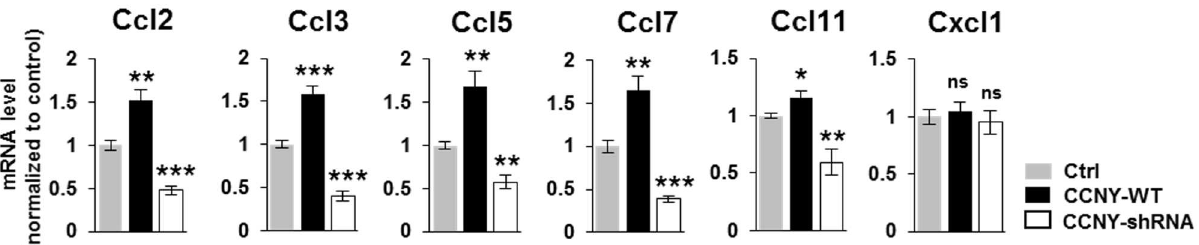
Fig 5. CCNY regulates genes related to Alzheimer’s Disease(AD) in hippocampal neurons. qRT-PCR results of severalcytokine genes in the chemokine signalingpathway (S3a Fig) or genes related to AD from CCNY overexpression or knockdown samples. n = 3–5 from 3 independentexperiments. * p < 0.05relative to control, ** p < 0.01 relative to control, *** p < 0.001relative to control, ns, not significant, student’s t test. Refer the S2 Table.